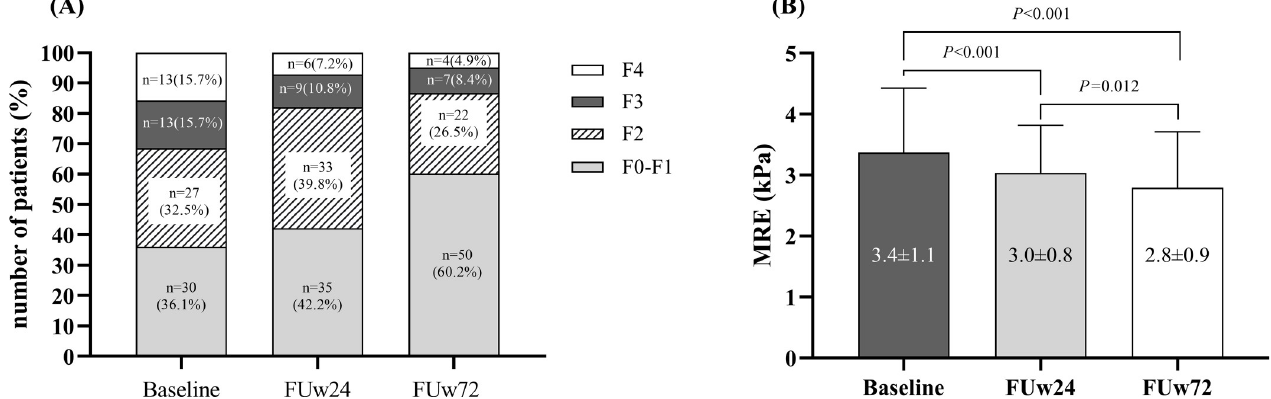
Fig 1. Changes of liver stiffness at baseline, FUw24 and FUw72 (A) Liver stiffness stages (B) Mean liver